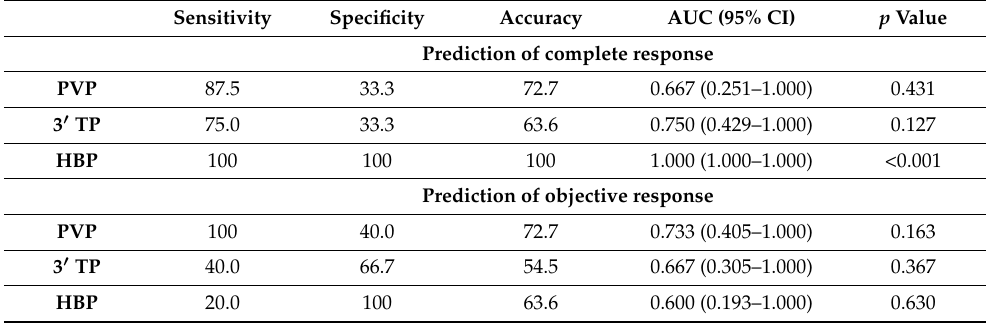
Table 4. Performance of logistic model with ridge penalty (radiomics model 1) based on the selected features for predicting complete response and objective response (complete and partial response) in the test set.